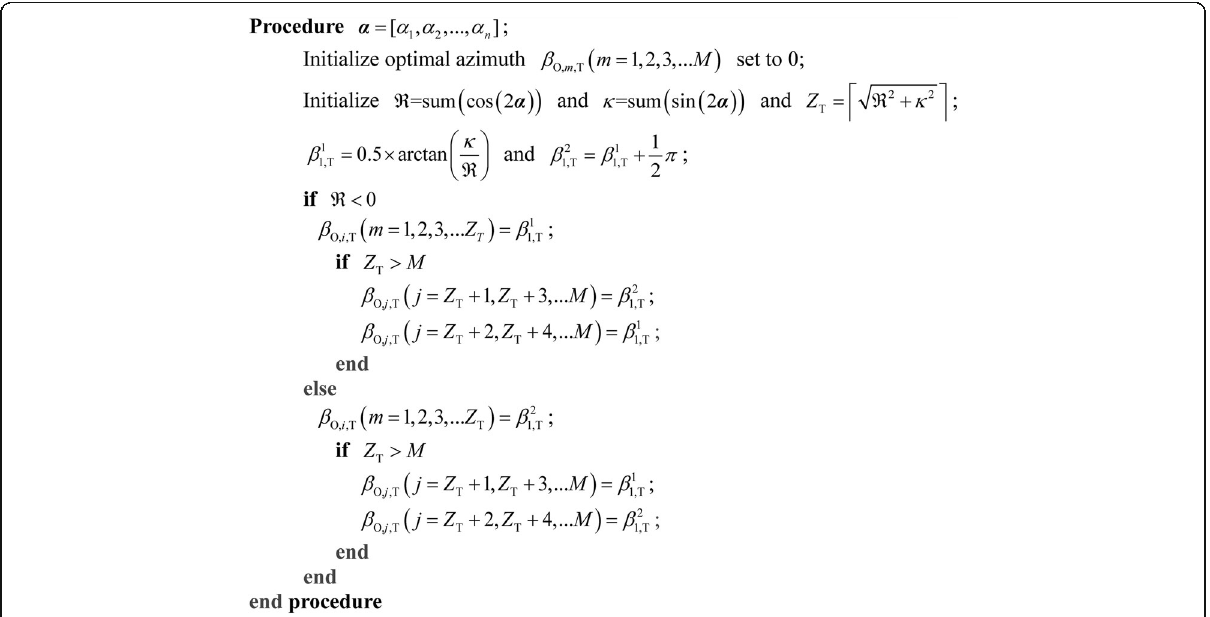
Fig. 11 Pseudocode for the deployment procedure in OPMPD approach towards TOA-based localization